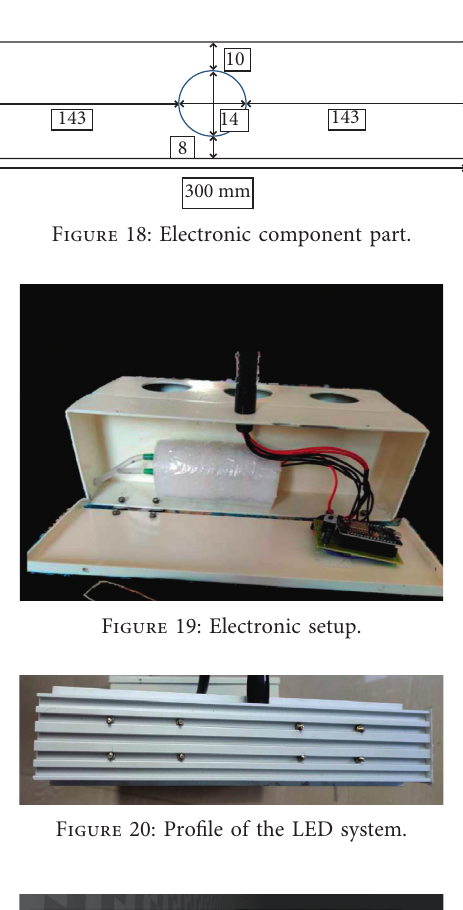
Figure 17: Plant holder part.